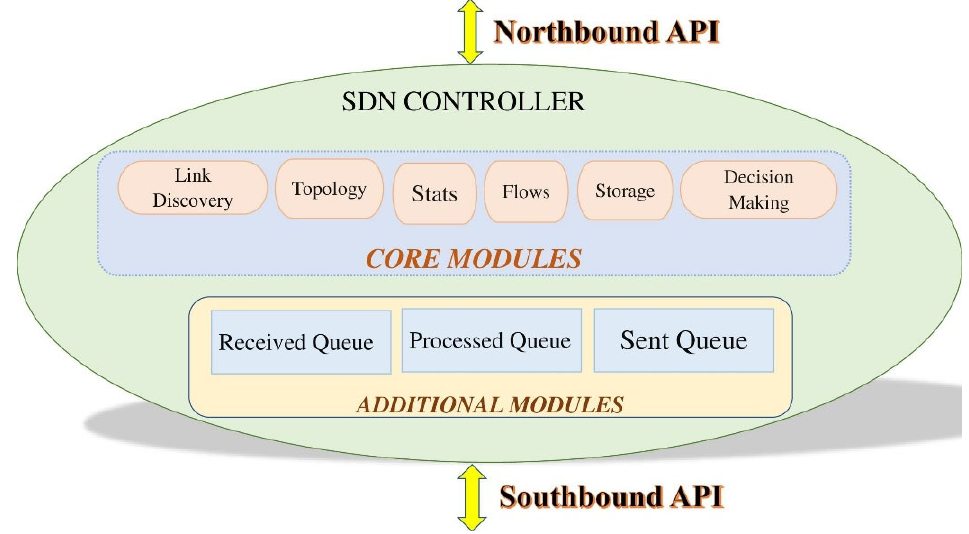
Figure 4. Workflow of control plane.